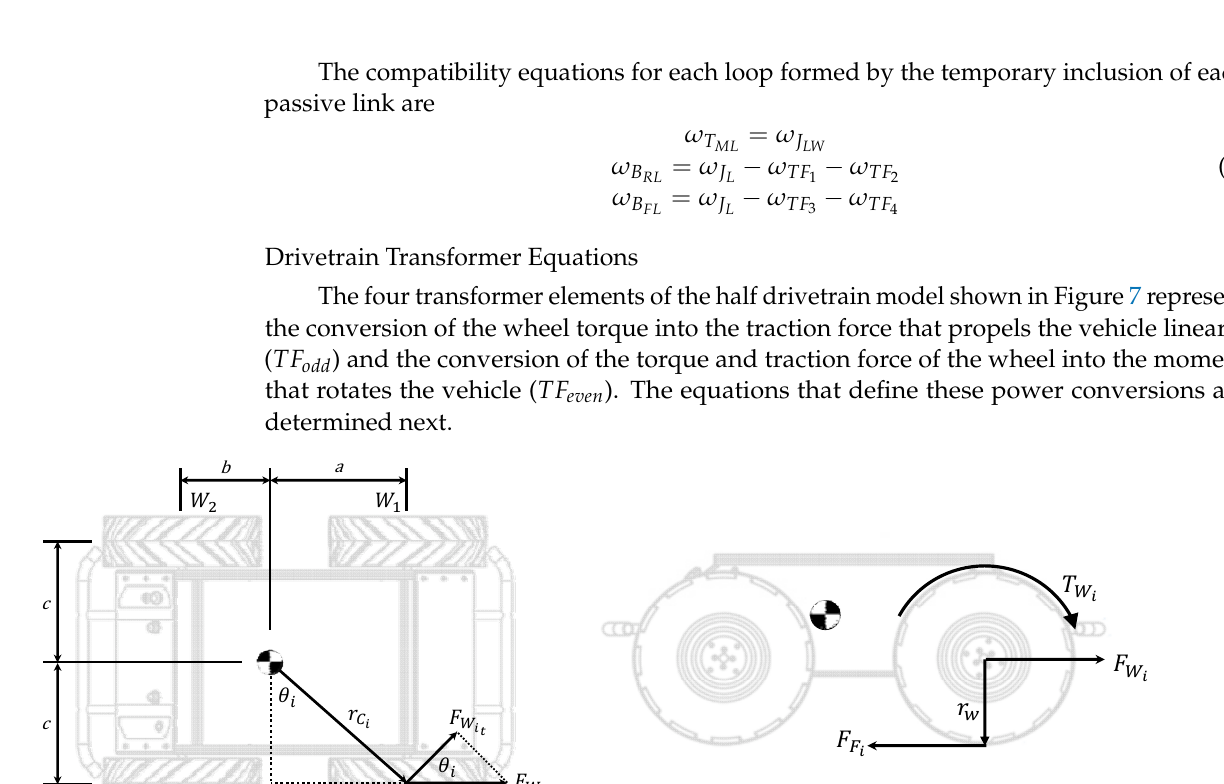
7 of 17 Figure 6. Simplified LG model and the normal tree of the left-side drivetrain subsystem. The equations produced by the LGtheory toolbox for the simplified drivetrain sub- system based on the constitutive equations and normal tree of the LG model are as fol- lows. The continuity equations for each passive branch are 𝜏 (cid:3011) (cid:3261)(cid:3272) = −𝜏 (cid:3003) (cid:3255)(cid:3261) − 𝜏 (cid:3003) (cid:3267)(cid:3261) − 𝜏 (cid:3021) (cid:3262)(cid:3261) 𝜏 (cid:3021)(cid:3007) (cid:3117) = 𝜏 (cid:3021)(cid:3007) (cid:3118) = 𝜏 (cid:3003) (cid:3267)(cid:3261) 𝜏 (cid:3021)(cid:3007) (cid:3119) = 𝜏 (cid:3021)(cid:3007) (cid:3120) = 𝜏 (cid:3003) (cid:3255)(cid:3261)